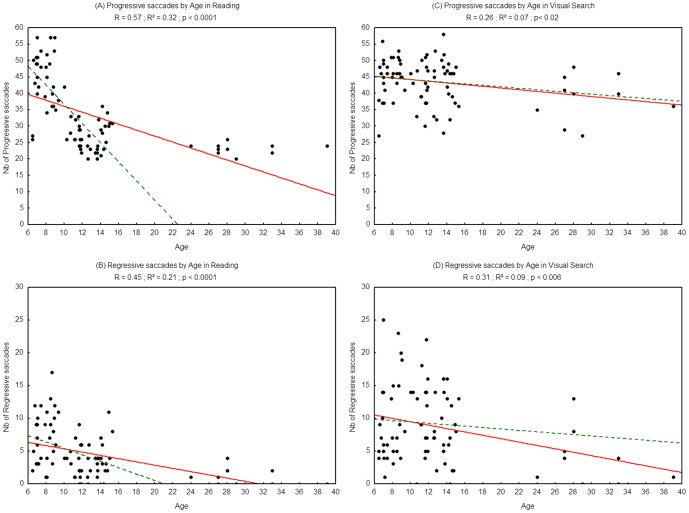
Number of progressive saccades during reading (A), visual search (C) and number of regressive saccades during reading (B) and visual search (D).Lines represent the corresponding regressions. Dotted lines represent the regressions for children (from 6 to 15 years old) only, 2A: R2 = 0.53, p<0.0001; 2B: R2 = 0.13, p<0.003; 2C: R2 = 0.009, p = 0.45; 2D: R2 = 0.003; p = 0.67.